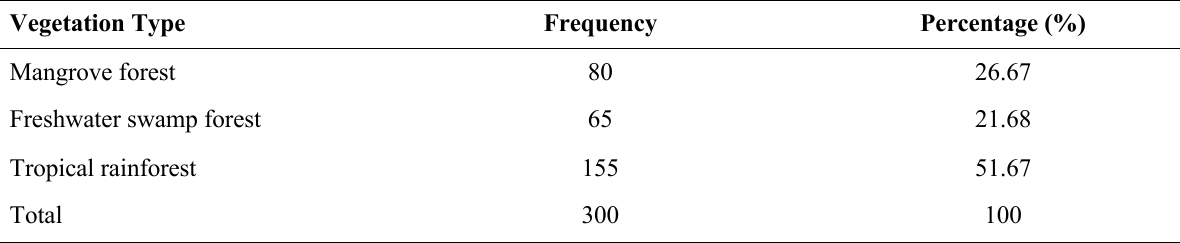
Table 1 : Respondents' View on the Most Exploited Vegetation Vegetation Type Frequency Percentage (%) Mangrove forest